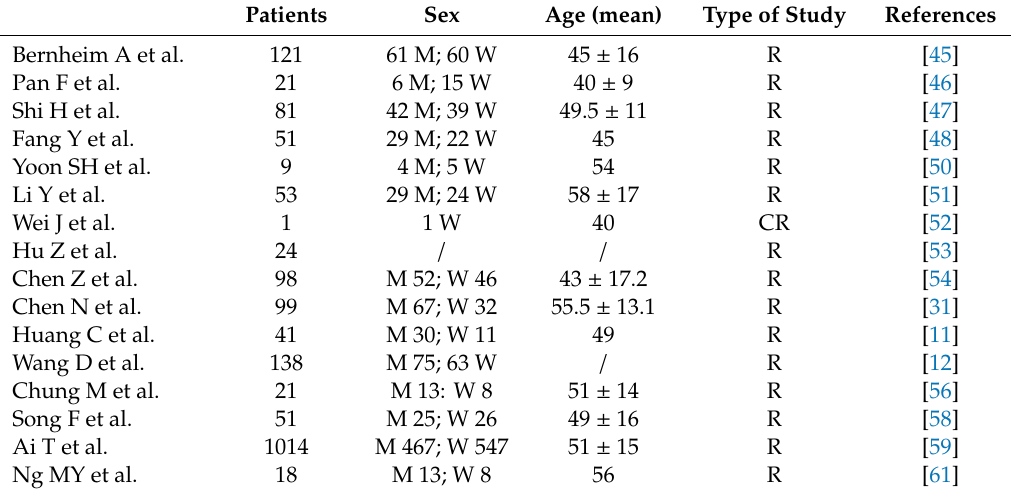
Table 3. Table reported the main studies with the computerized tomography (CT) characterization of SARS-CoV-2